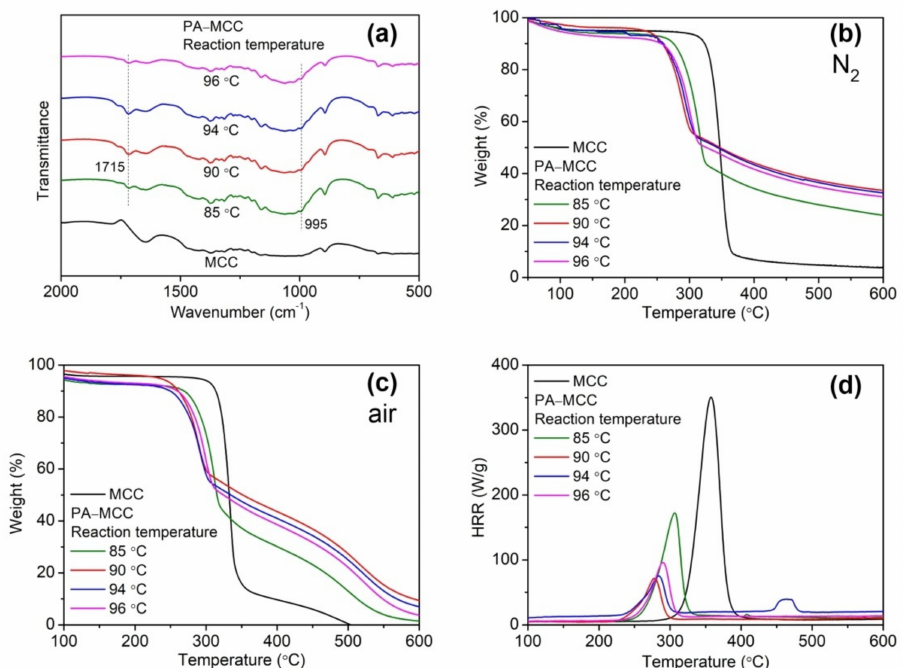
Figure 4. FT-IR ( a ), TG ( b , c ), and PCFC ( d ) analyses of PA-MCC obtained at various reaction temperatures. (PA concentration: 50%; MCC/PA weight ratio: 1:3; PA/urea/dicyandiamide weight ratio: 15:1:2; reaction temperature: 85, 90, 94 and 96 ◦ C; 4 h).